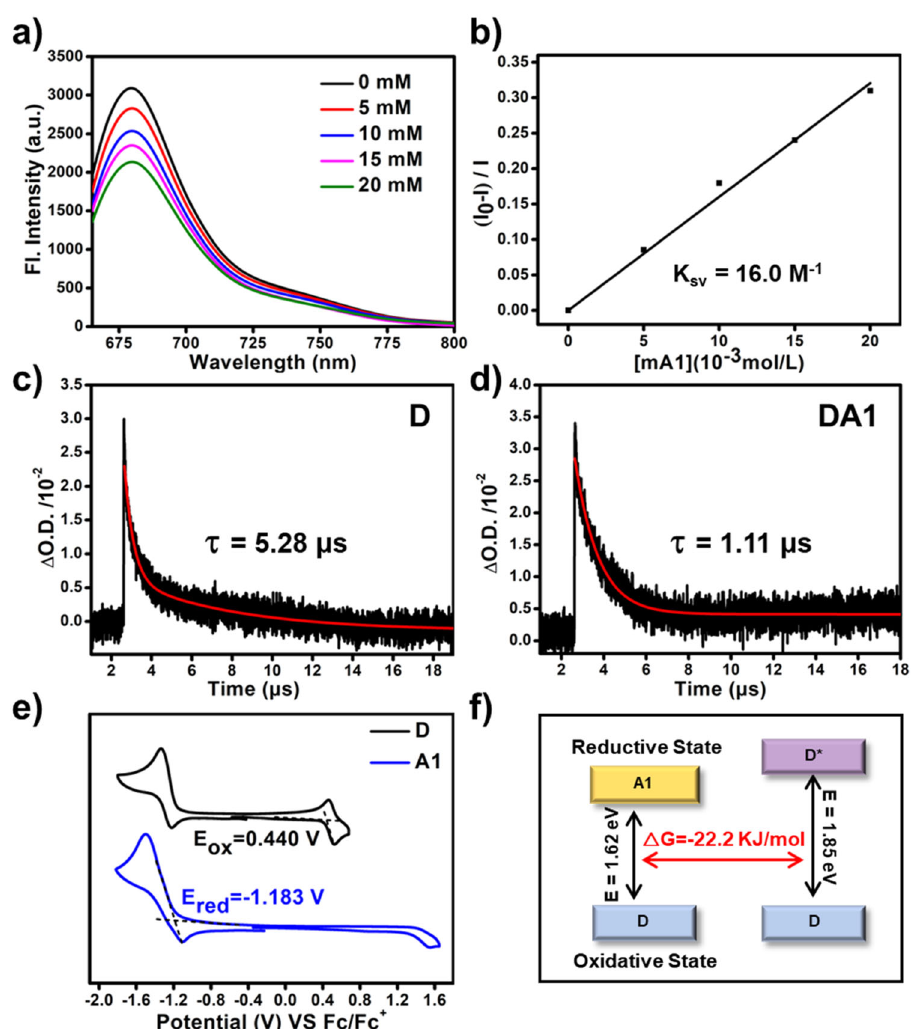
Fig.5|Thestudyofelectrontransfer.a Theemissionspectraof D (1.0×10 − 5 M)at 25°CinDMFwithincreasingamountsof A1 (0 – 20mM)underexcitationat650nm. b The Stern – Volmer plots for the fl uorescence quenching of D by A1 in DMF (I 0 is the fl uorescence intensity of D in the absence of A1 and I is the fl uorescence intensity in the presence of A1 at the different concentrations). Nanosecond tran- sientabsorptionspectra:Decaytraceof D inthe c supramolecularpolymerwithout